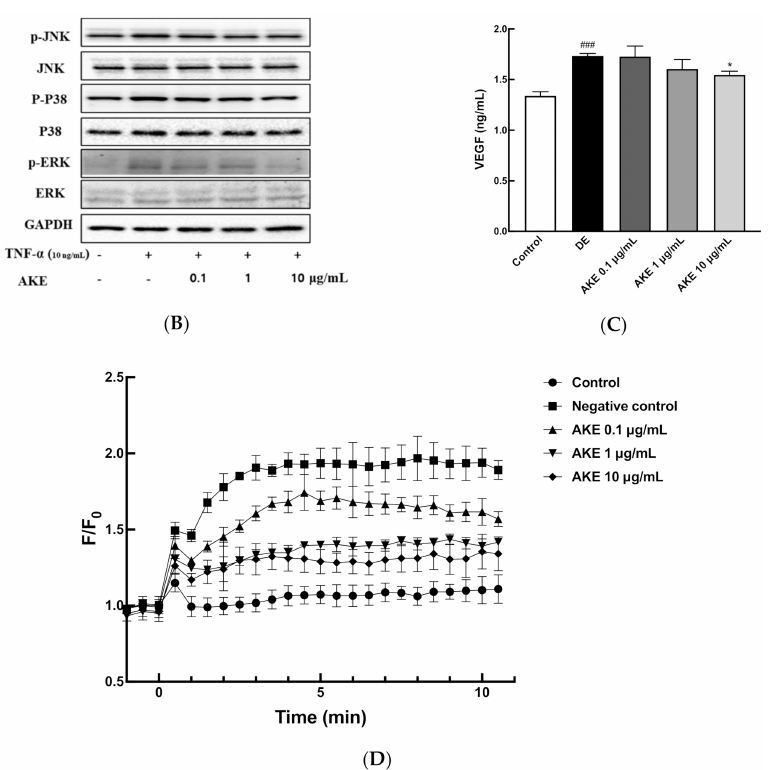
Figure 4. E ff ects of A. koraiensis ethanol extracts (AKE) on ER stress and the inflammatory response in animal model and human retinal pigmented epithelial (ARPE-19) cells. TNF- α -inducible pro-inflammatory gene expression in AKE-treated ARPE-19 cells. To induce an inflammatory reaction, phosphate bu ff ered saline (PBS) or 10 µ g / mL of TNF- α was treated, and AKE was treated in a dose-dependent manner (0, 0.1, 1, and 10 mg / mL). ( A ) Inflammatory cytokines were measured by qRT-PCR in order to validate the expression of each target gene (TNF-a, IL-1b, IL-6, IL-8, and MMP-9). glyceraldehyde 3-phosphate dehydrogenase (GAPDH) was used as an internal control. ( B ) The intracellular inflammatory signaling (MAPK) was analyzed using western blot (WB) with specific antibodies such as phospho-c-Jun N-terminal kinase (p-JNK), JNK, p-P38, P38, phospho-extracellular signal regulated kinase (p-ERK), and ERK. GAPDH was used for loading control. (C and D) endoplasmic reticulum (ER) stress was induced in ARPE-19 cells by thapsigargin (Tg), and AKE was treated with 0 (control; CON), 0.1 µ g / mL (AKE 0.1), 1 µ g / mL treatment (AKE 1), and 10 µ g / mL treatment (AKE 10). ( C ) Tg-induced VEGF- α expression was measured using ELISA. ( D ) Tg-induced calcium ion e ffl ux measurement using fluorescence. Data from three independent experiments have been presented as bar graphs showing mean ± SD. ### p < 0.001 versus CON; * p < 0.05, ** p < 0.01, *** p < 0.001 versus DE. Data were analyzed statistically using one-way ANOVA, followed by Tukey’s test. For [Ca 2 + ] i determination, two-way ANOVA with repeated measures was used, followed by Tukey’s hoc test. A, TC, D) Negative control to